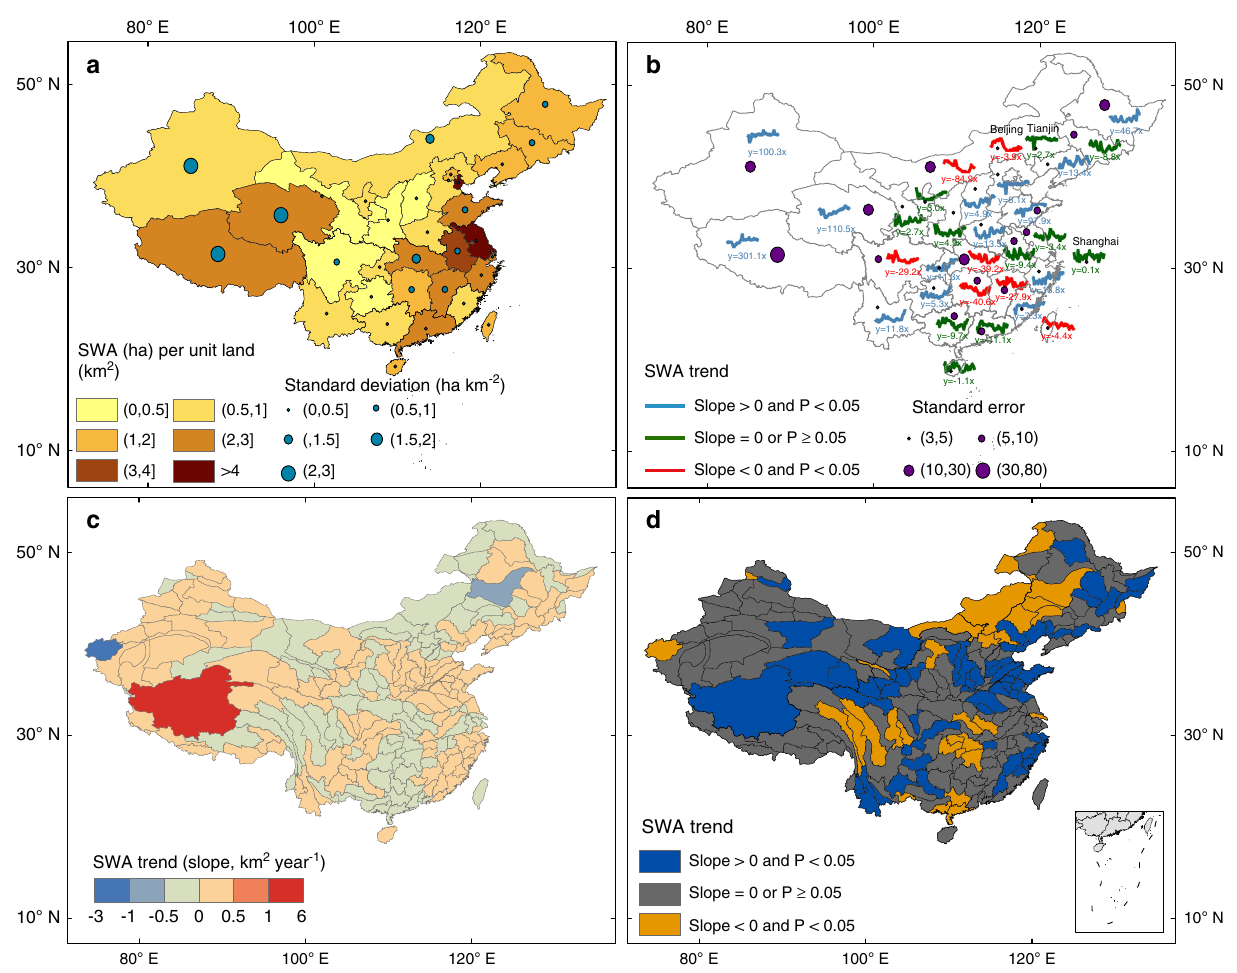
Fig. 2 Interannual variations and trends of year-long surface water area during 1989 – 2016 by province and watershed in China. a Average year-long surface water area (SWA) (ha) per unit land area (km 2 ) and standard deviation at the provincial scale. b Interannual trends of year-long SWA and standard errors at the provincial scale. c Interannual trends of year-long SWA at the watershed scale (slope value). d Interannual trends of year-long SWA at the watershed scale. Note that in 1996 SWA values in Tianjin, Hebei, and Shandong were extremely low ( b ), which was partially attributed to severe drought in the year. We analyzed the trend during 1989 – 2016 with 1996 data and without 1996 data, the slope values of the trend varied slightly in these three places. Here we keep the entire time series data in the graph, but only using the data without 1996 for regression (Fig. 2a). The mean of year-long SWA (ha) per unit land